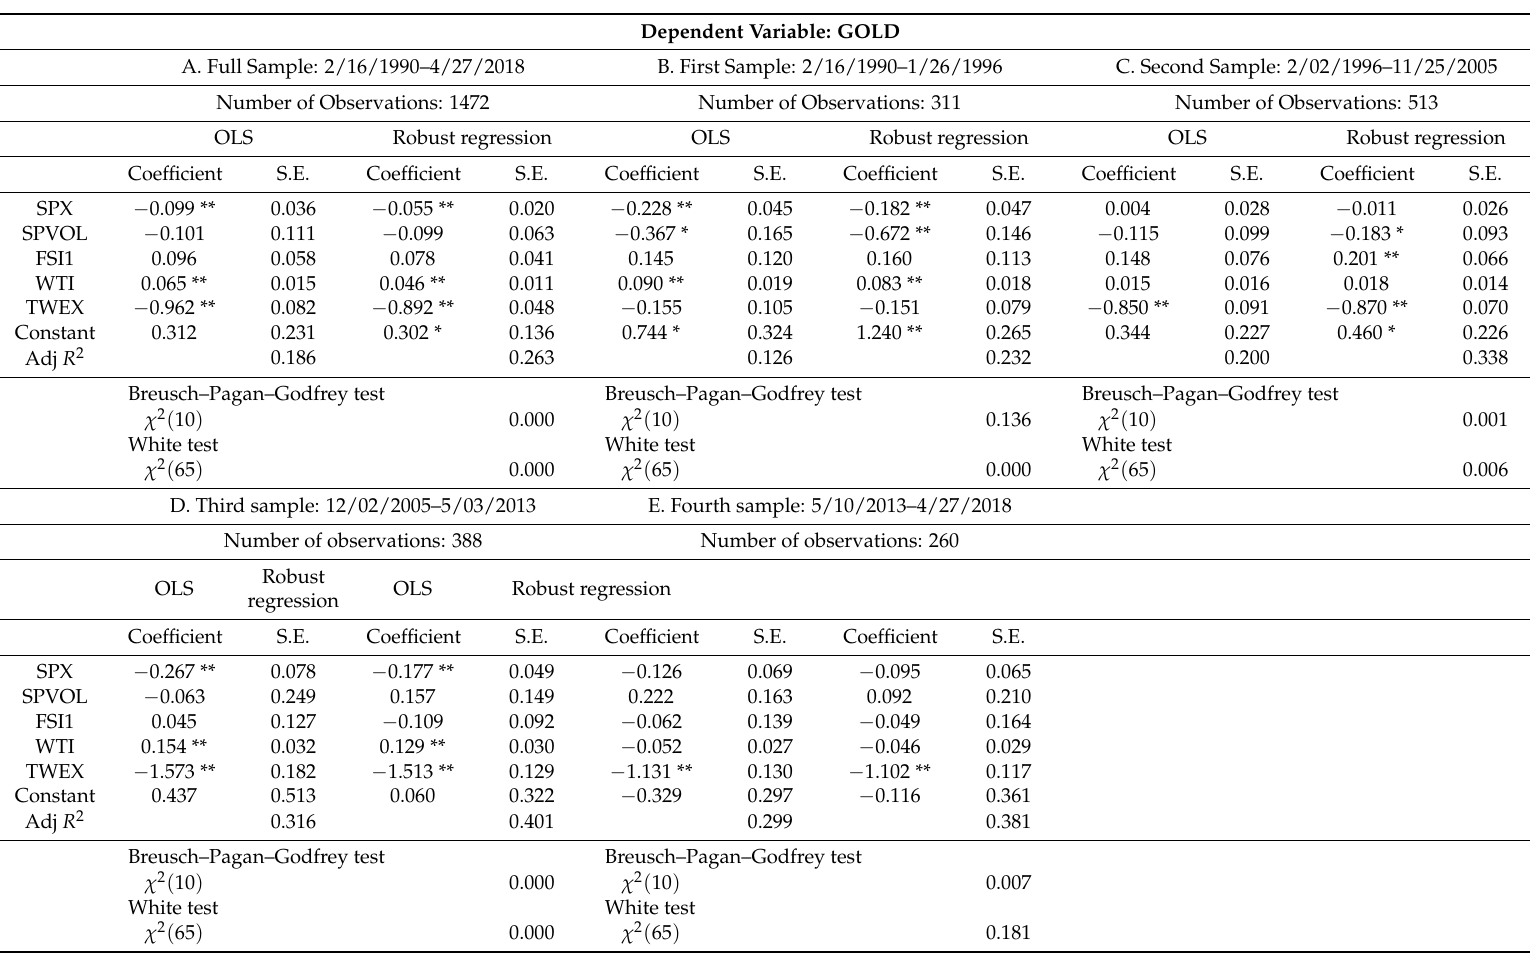
Table 5. OLS and robust regression